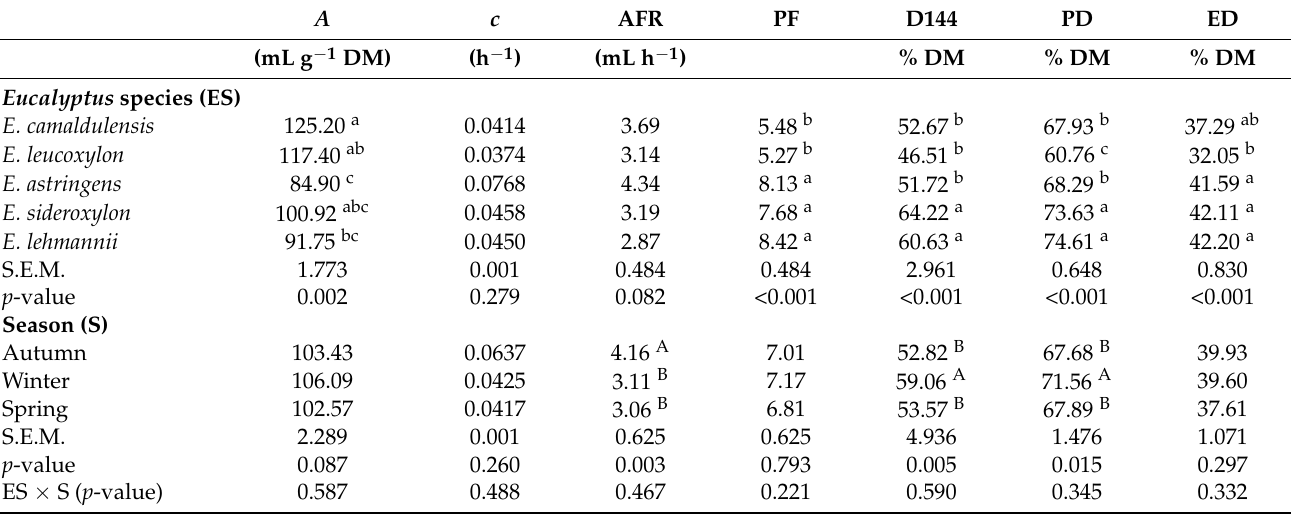
Table 2. In vitro gas-production kinetics of foliage from eucalyptus species harvested in different seasons.